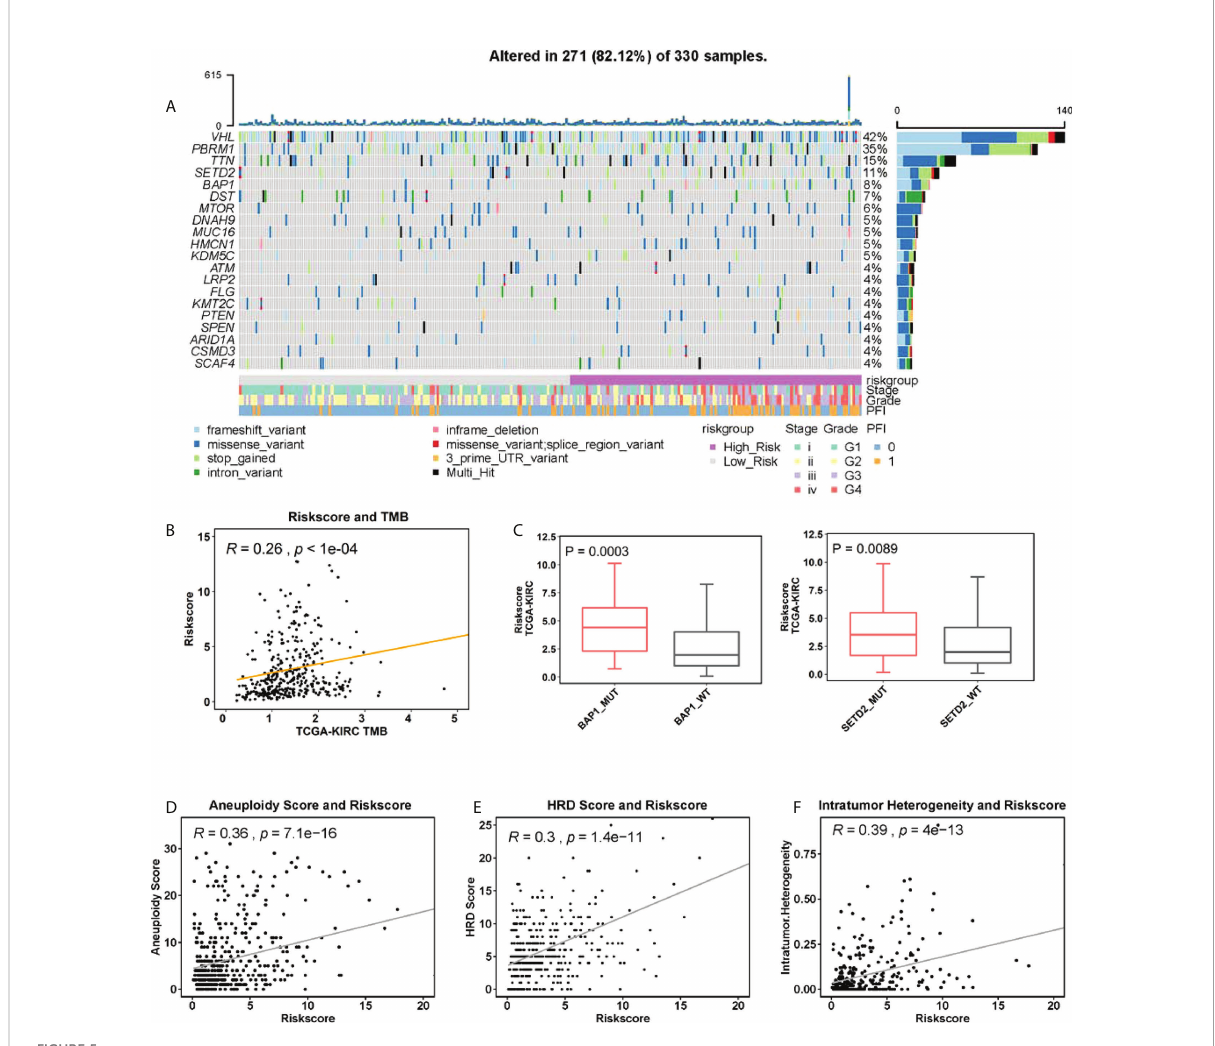
FIGURE 5 The association between genomic alterations and CuAGS-13 score in ccRCC. (A) The overview of the somatic mutations and relation to the CuAGS-13 score and clinical-pathological variables in the TCGA ccRCCs. (B) The positive correlation between CuAGS-13 score and tumor mutation burden (TMB) in the TCGA ccRCCs. (C) ccRCC tumors harboring BAP1 and SETD2 mutations exhibit signi fi cantly higher CuAGS-13 scores. (D) Positive correlation between the CuAGS-13 score and aneuploidy in ccRCC tumors. (E) Positive correlation between the CuAGS-13 score and homologous recombination de fi ciency (HRD) in ccRCC tumors. (F) Positive correlation between the CuAGS-13 score and intratumor heterogeneity in ccRCC